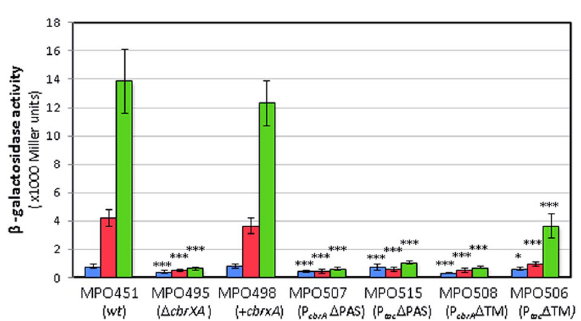
Figure 8. Expression levels of PP2810 in strains with Δ TM and Δ PAS truncated variants of CbrA. β -galactosidase activity was measured for pMPO420 ( PP2810 :: lacZ ) in strains MPO451 (wild type), MPO495 ( Δ cbrXA ), MPO498 ( Δ cbrXA - cbrXA ), MPO507 ( Δ cbrXA- PAS), MPO515 ( Δ cbrXA -P tac Δ PAS), MPO508 ( Δ cbrXA - Δ TM) and MPO506 ( Δ cbrXA- P tac Δ TM). Bars represent the averages and standard deviations of at least three independent assays. Stars designate p-values for the Student’s t-test for unpaired samples not assuming equal variance. * p < 0.05; ** p < 0.01; *** p < 0.005 comparing with MPO498 transcriptional